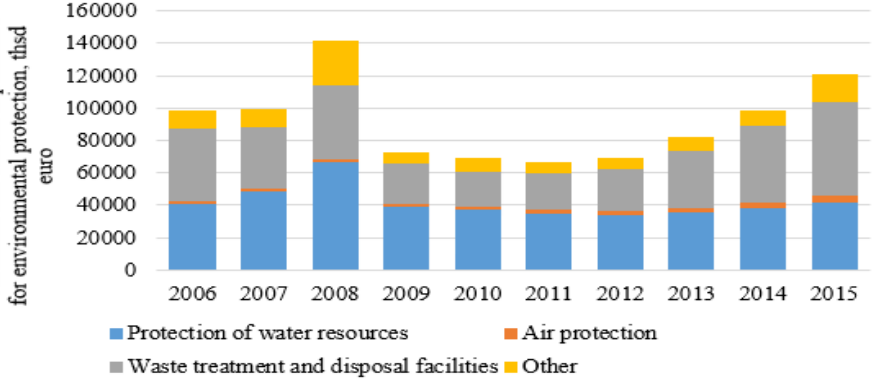
Fig. 1. Investments and current expenditure for environmental protection by environmental area in Latvia (thsd euro excluding VAT) Data: Central Statistical Bureau of Latvia (2017) . [Figure developed by